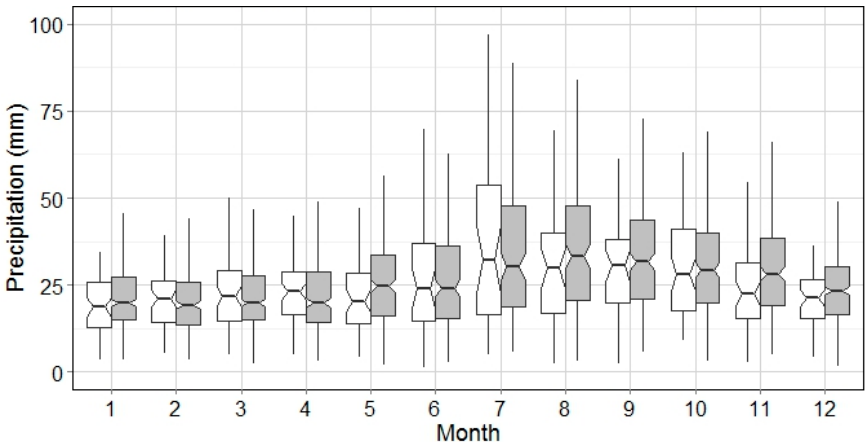
Figure 9. Boxplots of WEP means with WED longer than 10 h (Historical: White, Synthetic: Grey).